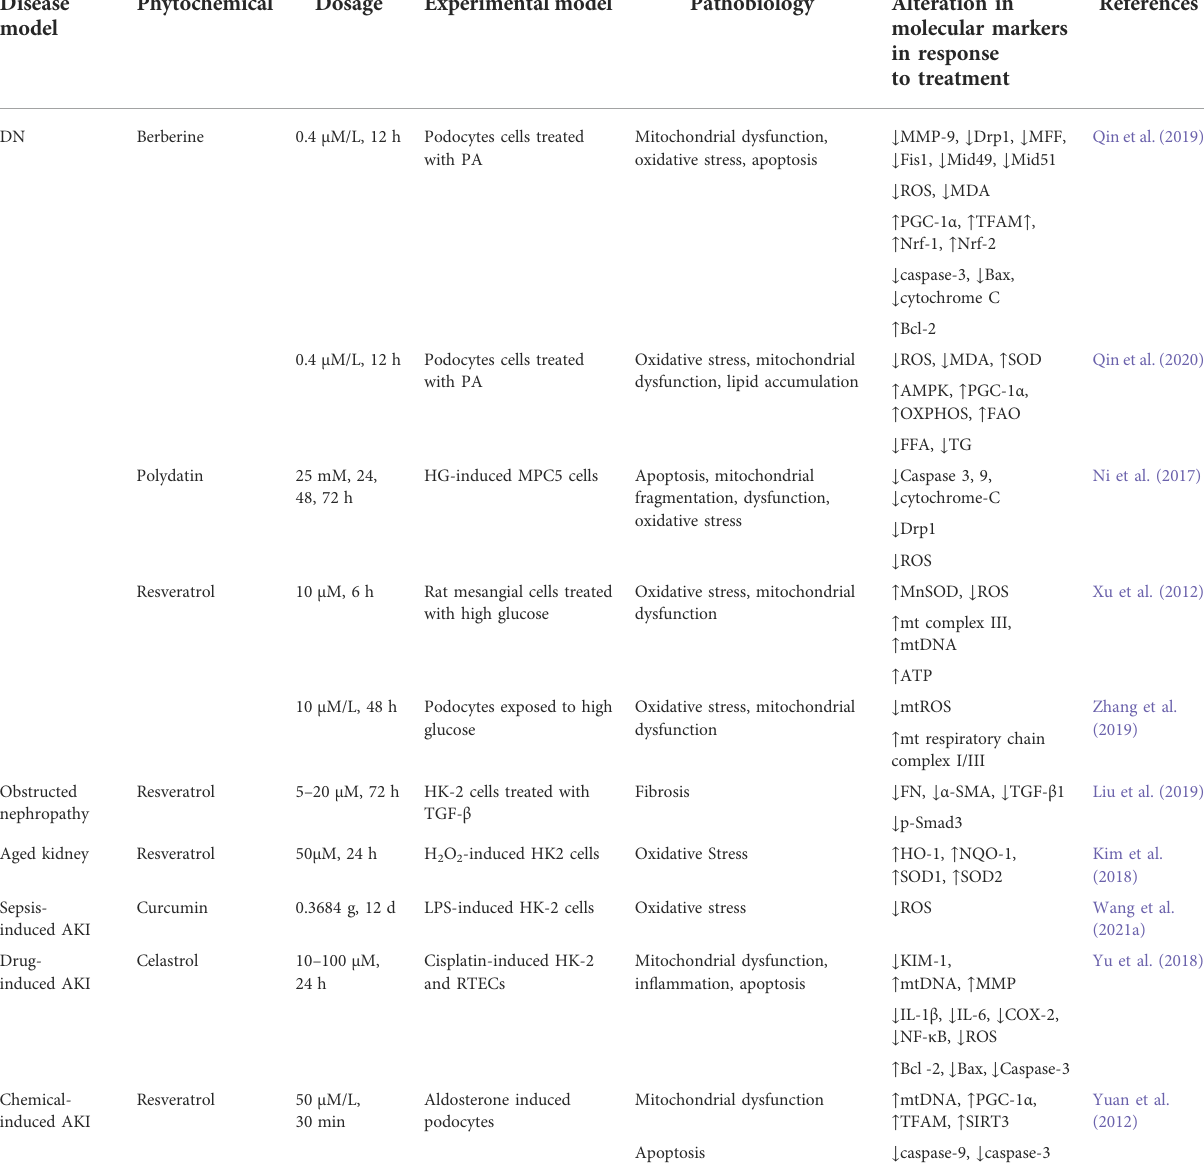
TABLE 2 Kidney protective effects are provided by phytochemicals targeting the mitochondrial fi tness in cellular